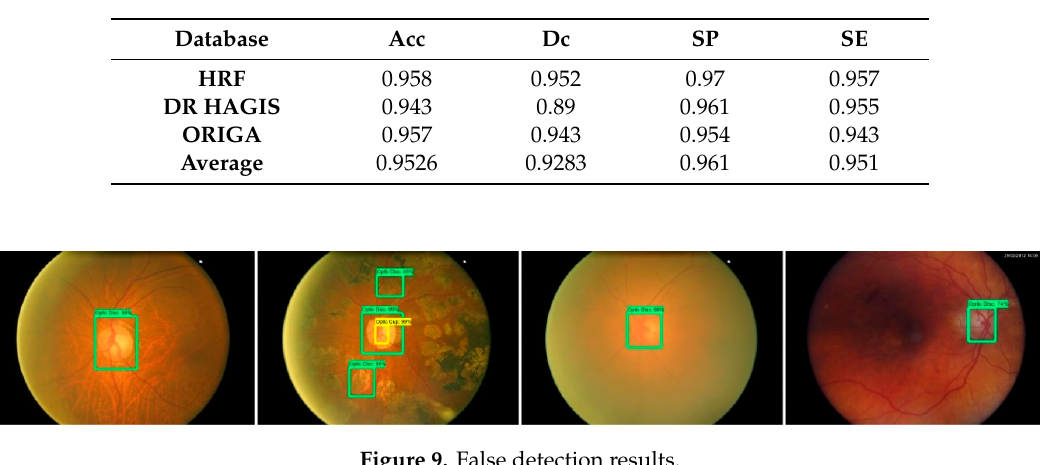
Figure 9. False detection results.